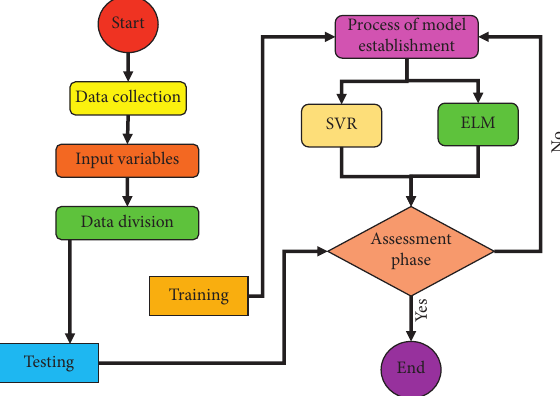
Figure 5: TDG prediction model